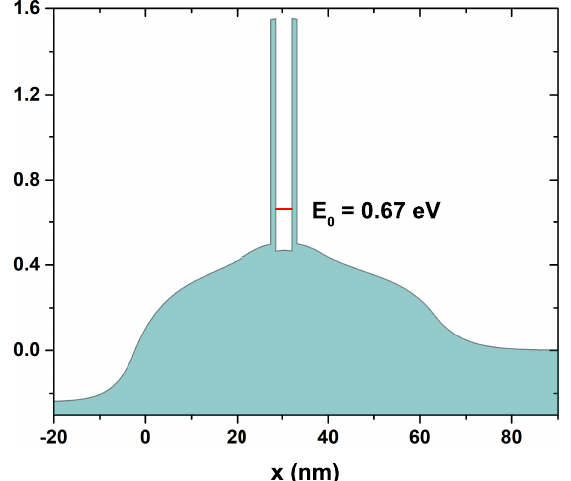
Figure 11. Self-consistent potential corresponding to the conduction band obtained numerically with the experimental parameters detailed in Table